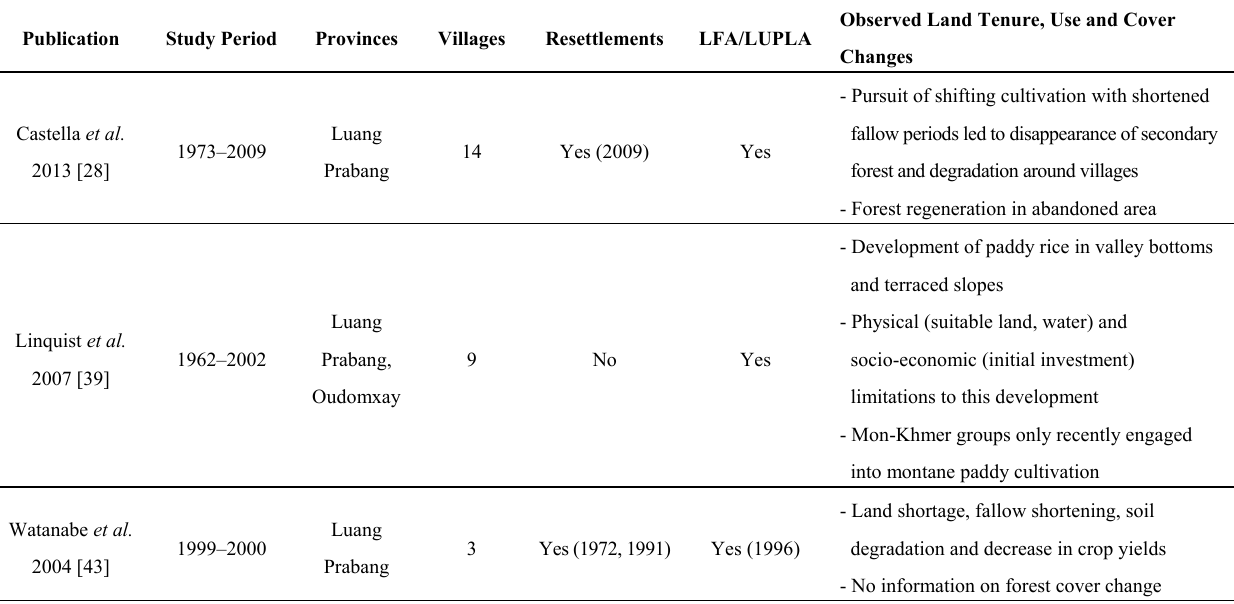
Table 6. Case studies of resettlement, land planning and impacts in